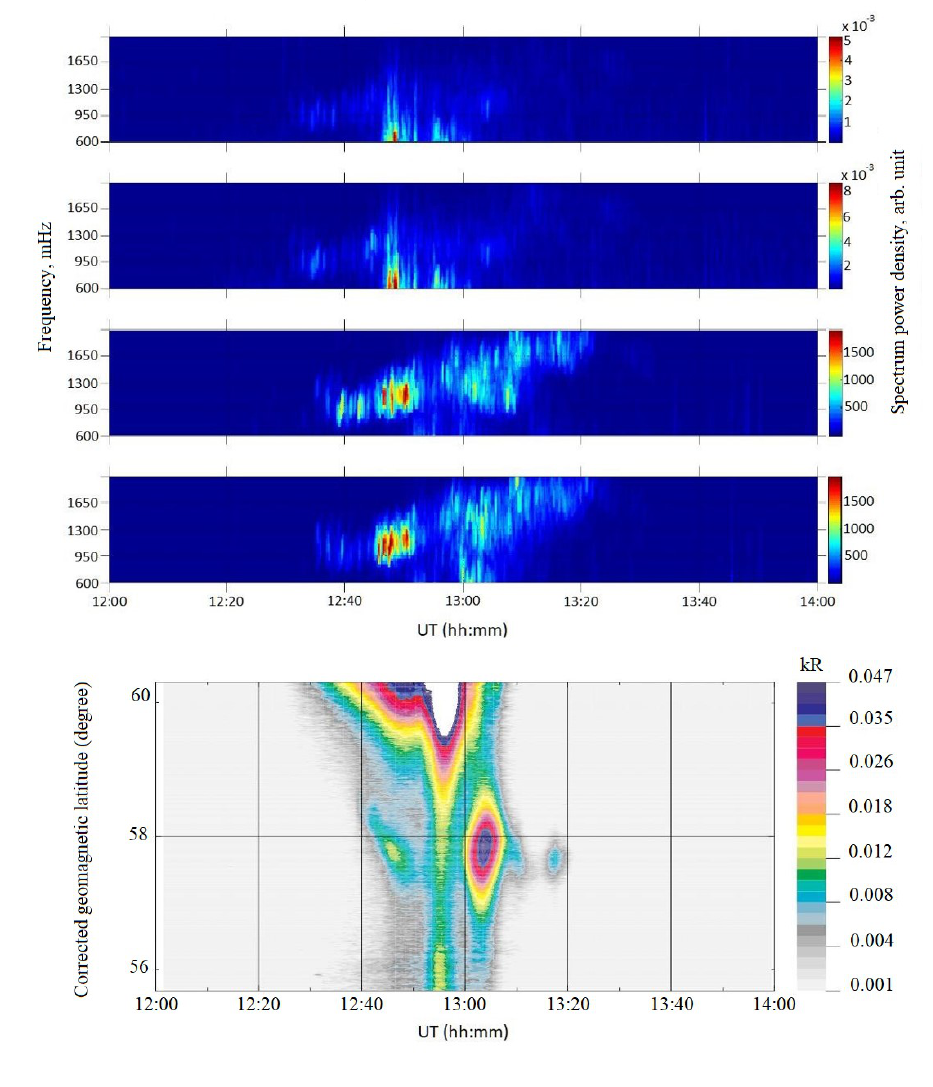
Fig. 3. From top to bottom, spectrograms of the H and D components at Zhigansk and Yakutsk stations, and the latitudinal keogram of the luminosity in the 486.1 nm emission at 110 km during observations on March 1, 2017 at 12:00-14:00 UT. The signal intensity is given in kilo